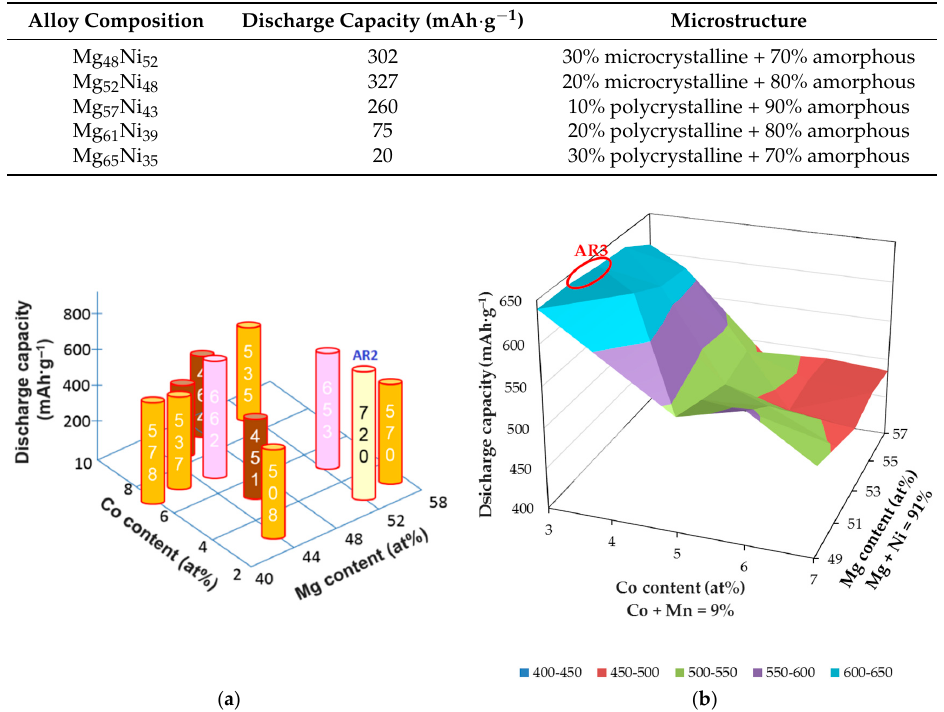
Figure 2. Maximum discharge capacities of ( a ) Mg-Ni-Co ternary and ( b ) Mg-Ni-Co-Mn quaternary thin films deposited on liquid nitrogen-cooled nickel substrates with 50 mA·g − 1 charge and discharge current densities. AR2 (Mg 52.1 Ni 45.1 Co 2.8 ) and AR3 (Mg 52 Ni 39 Co 3 Mn 6 ) are identified as compositions corresponding to the highest discharge capacities.